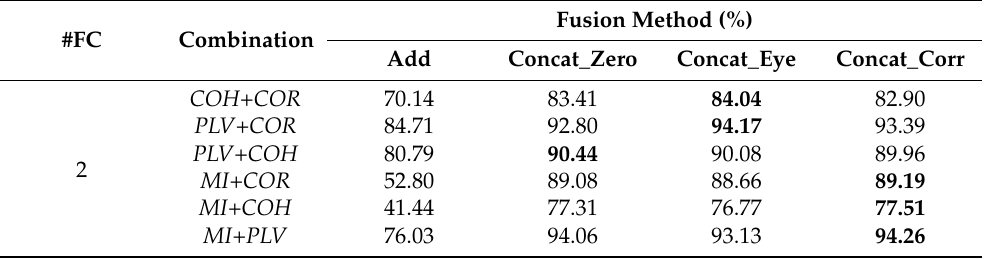
Figure 5. Classification accuracy comparison by using single FC and multiple FCs in the case of channel reducing. Left: accuracy by using four single FCs under 64 channels (grey bars) and 32 channels (purple bars). Right: accuracy by using six two-FC combination under 32 channels. When the number of channels is reduced to half of the original, the accuracy of the FC combination using the concat-fusion is higher than by using single FC. Especially in the combination containing PLV ( PLV+COR , PLV+COH , and MI+PLV ), the best result is up to 94.26%, which is almost the same as the optimal single channel under 64 channels. Table 4. Accuracy of two-FC combination in different fusion methods under 32 channels.